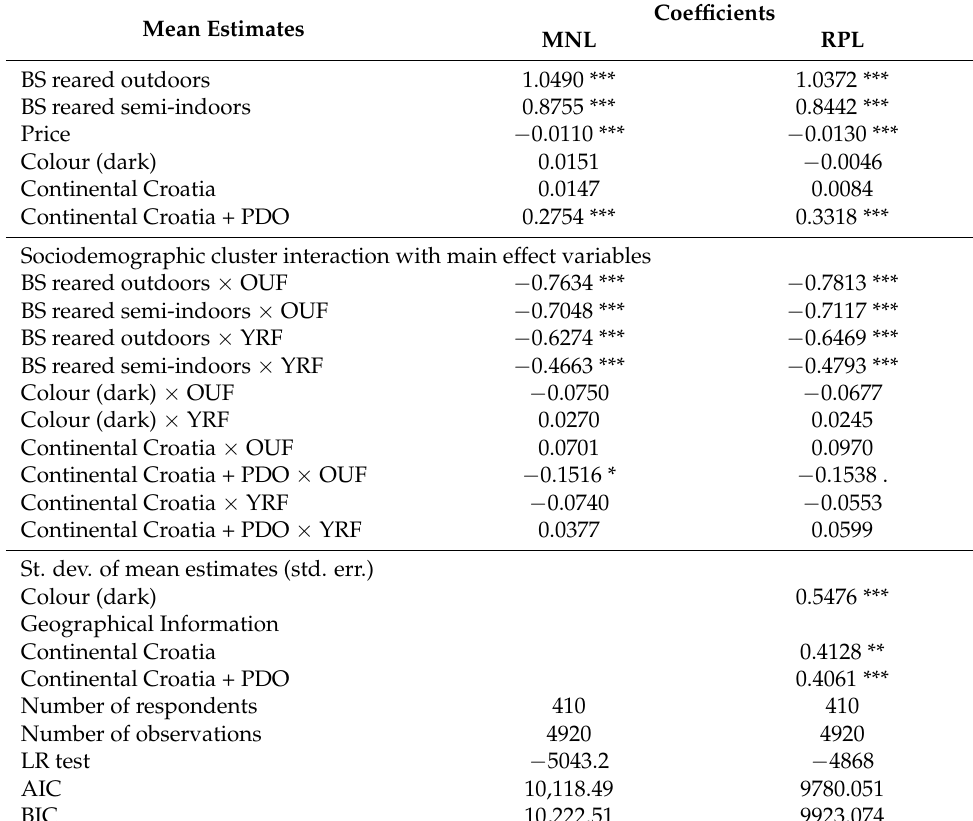
Table 4. Estimated parameters of the MNL and RPL models and interaction of sociodemographic clusters with main effect variables.